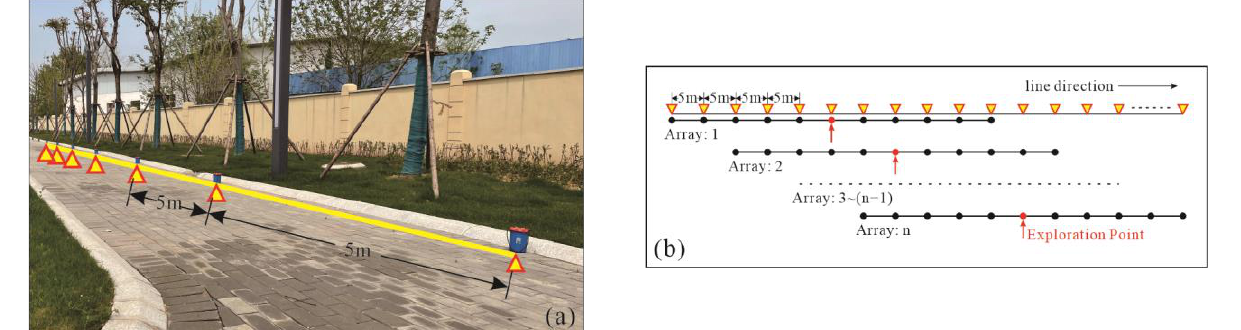
Figure 2. Schematic layout of the microtremor linear array. ( a ): photographs of field work; ( b ): diagram of the roll-along acquisition mode.